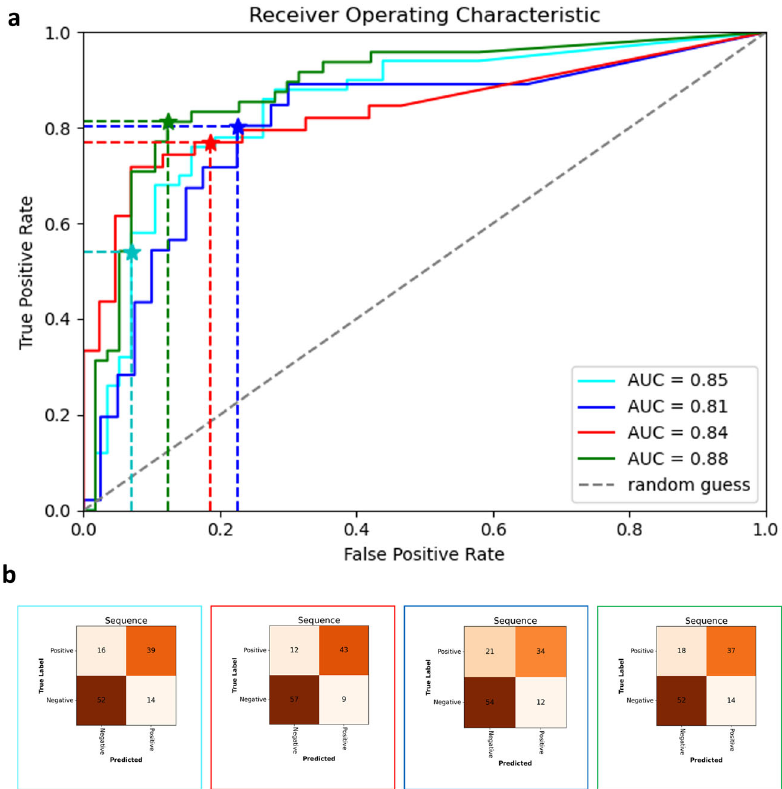
Fig. 4 Evaluation results for ESV1 on compression sequence level. Receiver operator characteristics for the correct compression classi fi cation per ultrasound sequence/anatomical landmark on EVS1 ( a ). Confusion matrices ( b ) at optimal thresholds (* in ( a )) per fold. Frame colours correspond to ROC fold colours in ( a ). Vessel status is extracted automatically through the ML models from the 121 available anatomical landmark sequences in